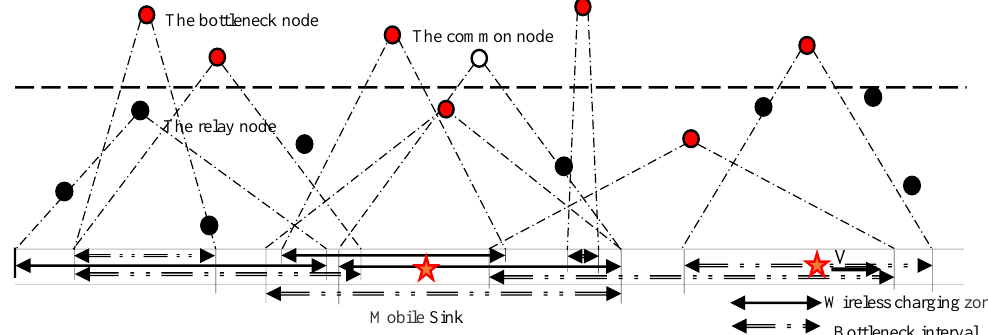
Figure 2. A strip space of WRSN with different regions.